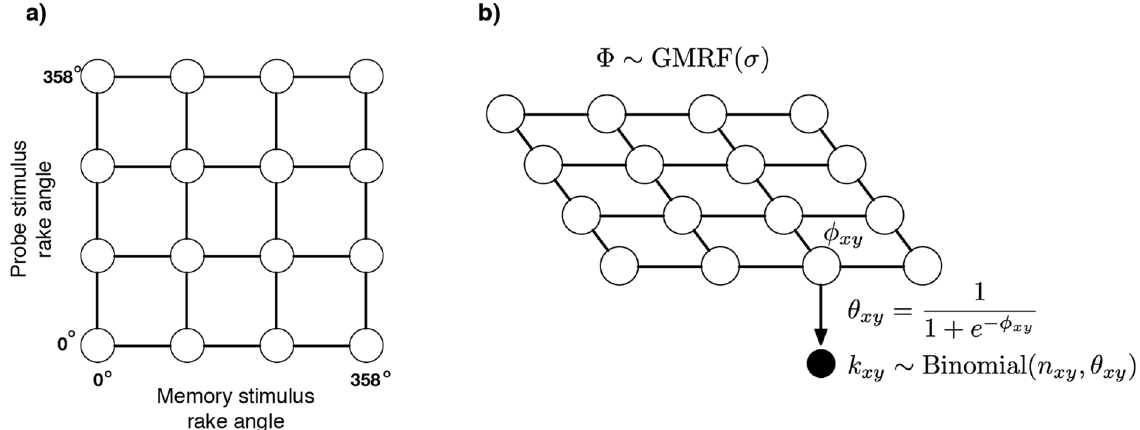
Figure 7. Gaussian Markov Random Field (GMRF) used to analyze visual change detection performance. ( a ) A 2D lattice defined over all memory–probe pairs. The figure shows a 4 × 4 lattice for simplicity, the actual analysis used a 180 × 180 lattice. ( b ) A probabilistic graphical model connecting latent Gaussian values defined by a GMRF to the experimentally-measured change detection data. (Figure generated using Adobe Illustrator